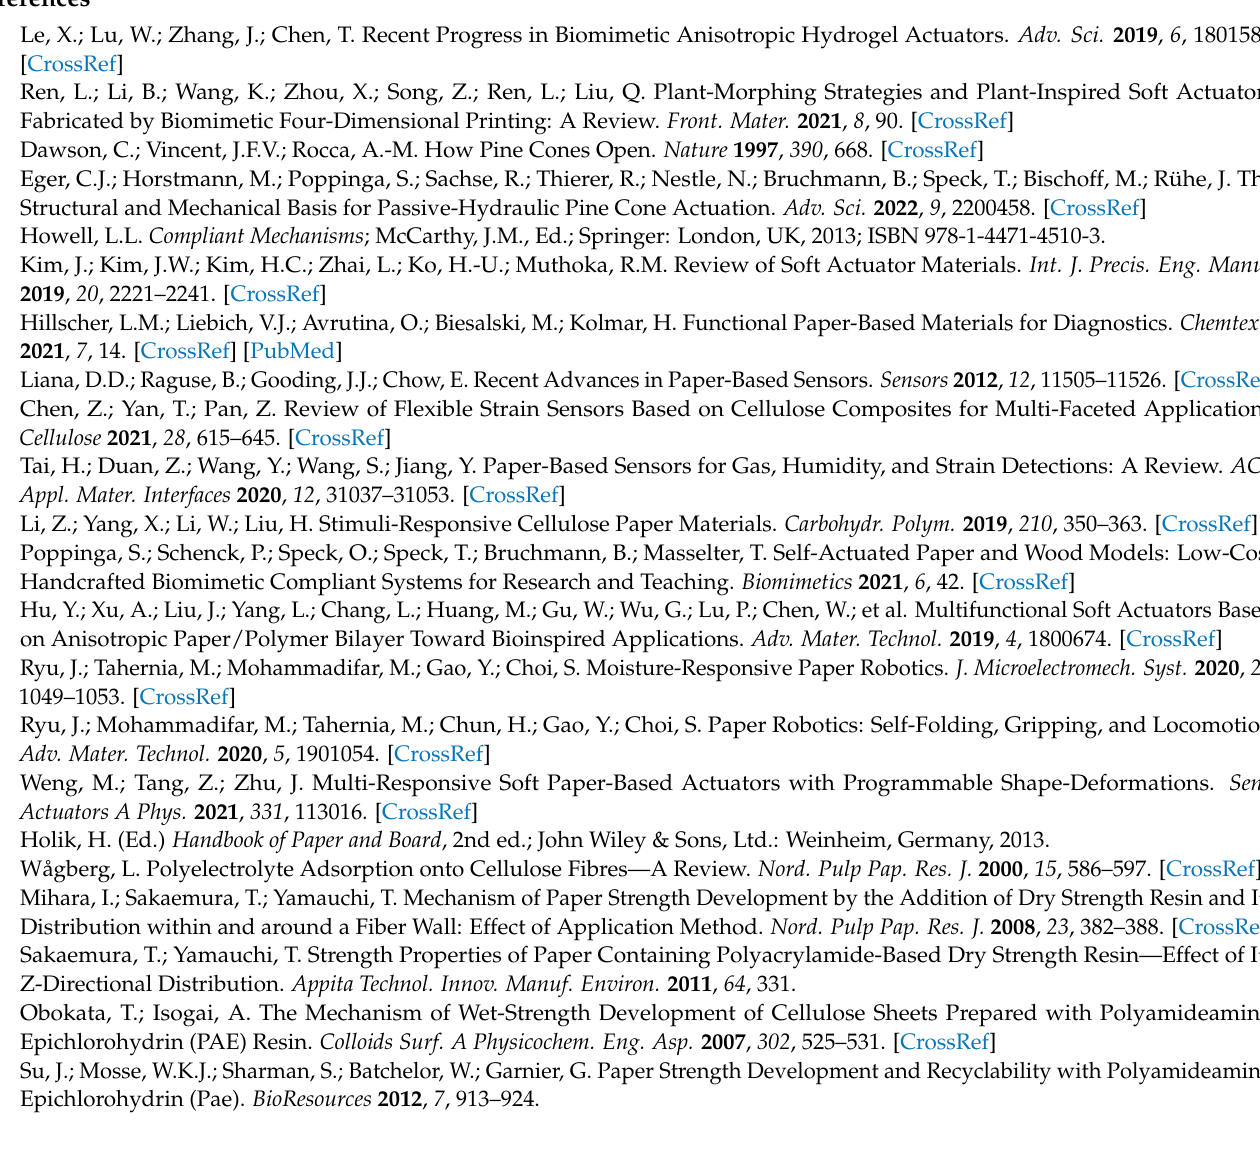
the dry paper weight; Table S3: Dynamic vapor sorption measurement results of eucalypt sulphate paper with 100 g/m 2 unmodified and modified with the copolymer applied out of IPA,